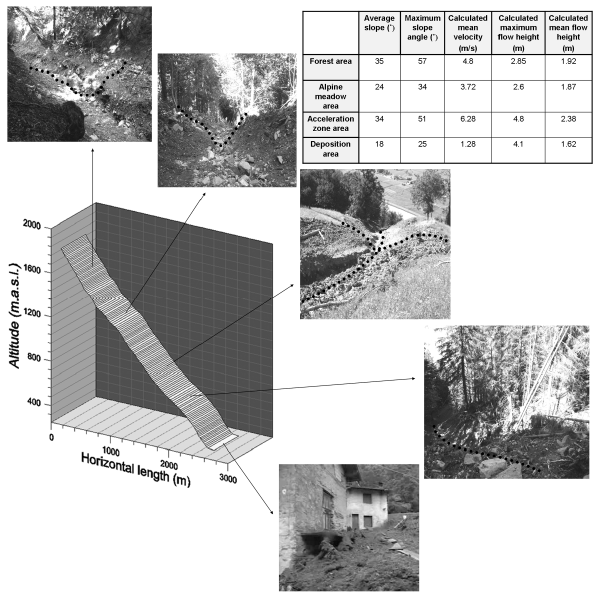
Fig. 3. Selvetta debris flow path including the calculated mean ve- locity, maximum flow height, and mean flow height for each mor- phologic section. Fig. 4. Derived hydrograph of the debris flow, including the re- leased volume and peak discharge (above) obtained from the hourly precipitation records from the Morbegno rain gauge